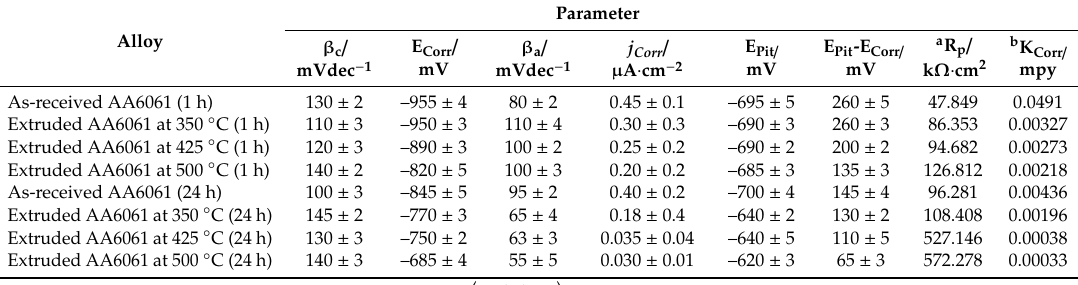
Table 1. Corrosion data gathered from polarization curves of Al alloys in the chloride solutions. Parameter Alloy β c / mVdec −